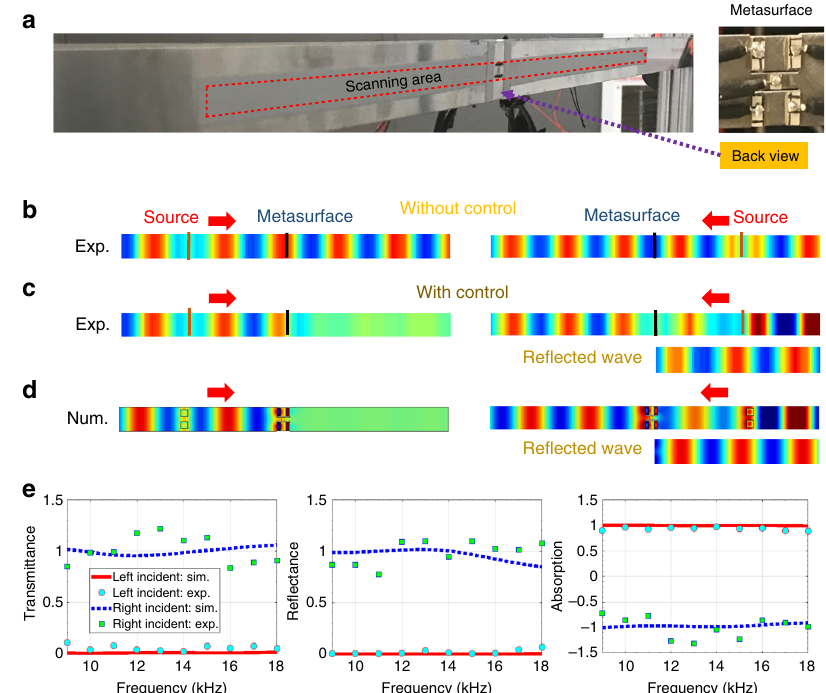
Fig. 3 Experimental demonstrations of the Willis meta-layer in beams. a Schematic of the experimental setup. Parameters of experimental setup are given in Supplementary Fig. 4 and Supplementary Table 2. b Experimentally measured wave fi eld without control (circuit is switched OFF). Source data are provided as a Source Data fi le. c Experimentally measured wave fi eld with control (circuit is switched ON). Source data are provided as a Source Data fi le. d Corresponding numerical simulations to validate the results in ( c ). e Experimentally measured and numerically simulated transmittance, re fl ectance and absorption for frequencies from 8 to 18 kHz demonstrating the recon fi gurable broadband operability. Source data are provided as a Source Data fi le.